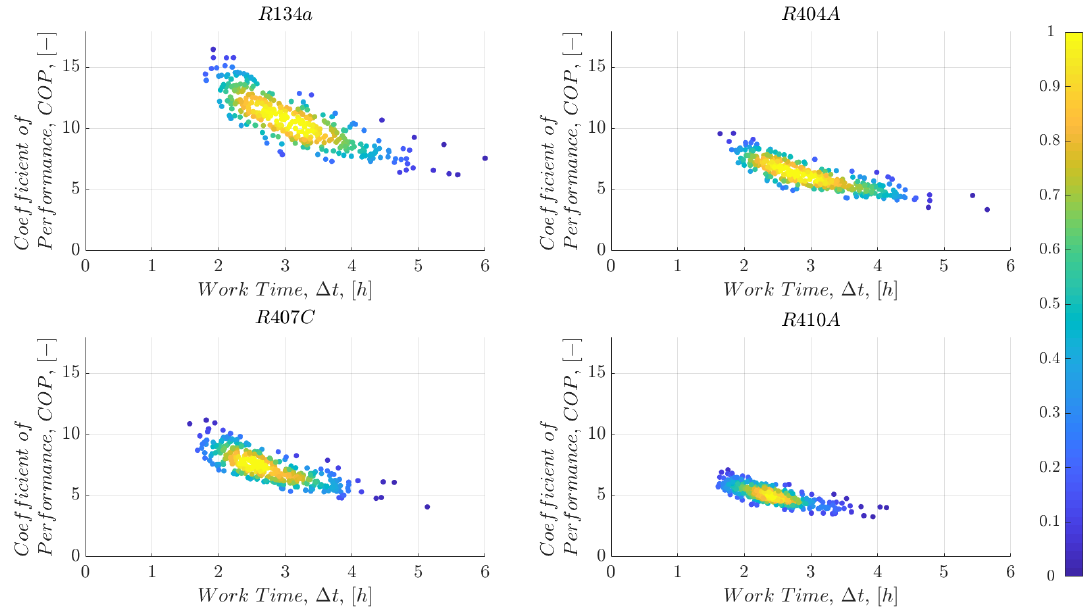
Figure 28. Probability density estimation of the work time as a function of the coefficient of performance for all the working fluids employed.